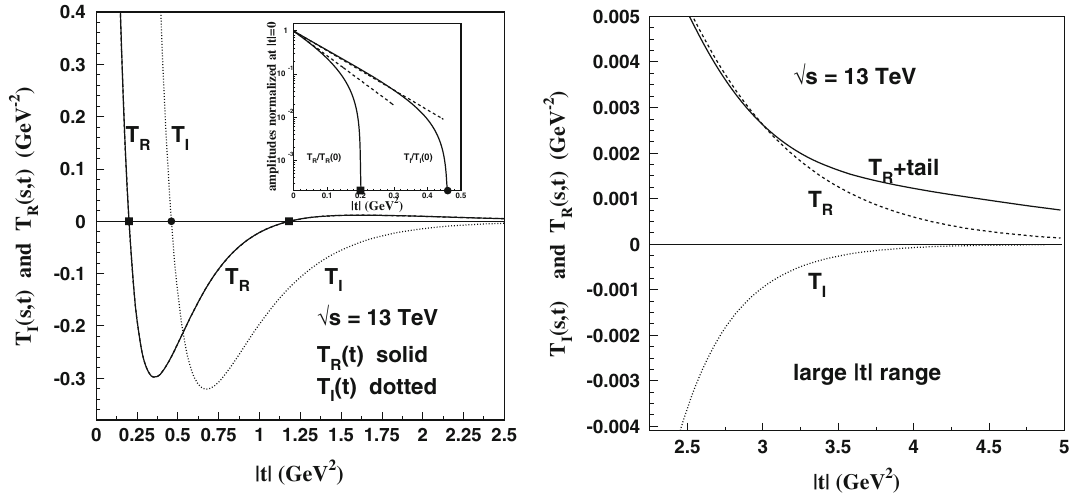
inary amplitude (dotted line) becomes negligible, and there is strong Fig. 6 | t | dependence of the real and imaginary parts of the pp elastic √ s = 13 TeV, showing one zero at Z I = 0 . 46 GeV 2 for dominance (in magnitude) by the positive real part (dashed line). For amplitude at | t | above ∼ 3GeV 2 the three-gluon exchange contribution added to the = 0 . 200 GeV 2 and Z ( 2 ) = 1 . 180 GeV 2 for T I ( t ) , and zeros at Z ( 1 ) R R real part (solid line) raises d σ/ dt , forcing the behaviour observed at √ T R ( t ) . The inset uses log scale to exhibit the slopes at | t | = 0, demon- s = 27 . 4GeV and conjectured to be universal. The continuity in the strating the early deviation of the amplitudes from the linear behaviour, inclusion of the three-gluon exchange term is shown in Fig. 5 eachamplitudebendingtowardsitszero.Forlarge | t | thenegativeimag-